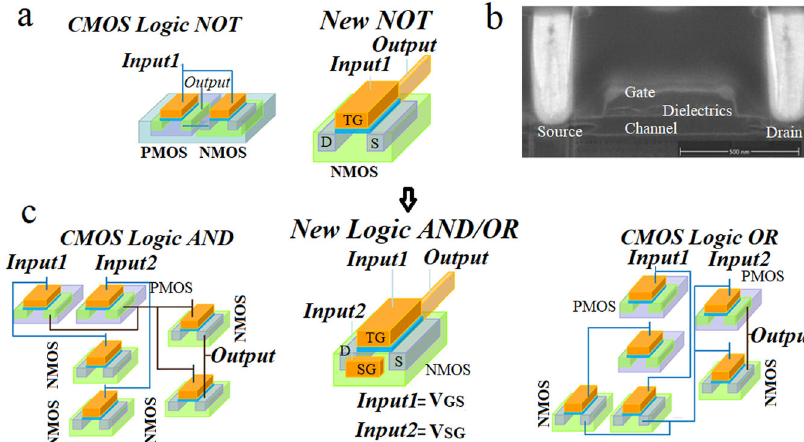
Fig. 1 Schematics of the one-transistor design for implementing logic gates. a Logic NOT gates comparing the conventional CMOS design (left) and the one-transistor design (right; TG: top gate). b Cross-section SEM view of the device fabricated using the Si-based SOI 130 nm technology node (scale bar: 500 nm). c One-transistor logic AND/OR gate in comparison to the six-transistor logic gates. The fi rst input, Input1 , is the voltage on the top gate, V GS , and the voltage on the side gate (SG), V SG , is the second input, Input2 . The voltage on the drain electrode is V DS , and the channel current is I DS . The additional electrode connected directly to the channel represents the output of the logic gates and is the control gate of the memory. The voltage measured from the output is denoted as Output , and the voltage applied on the control gate is V CG 22